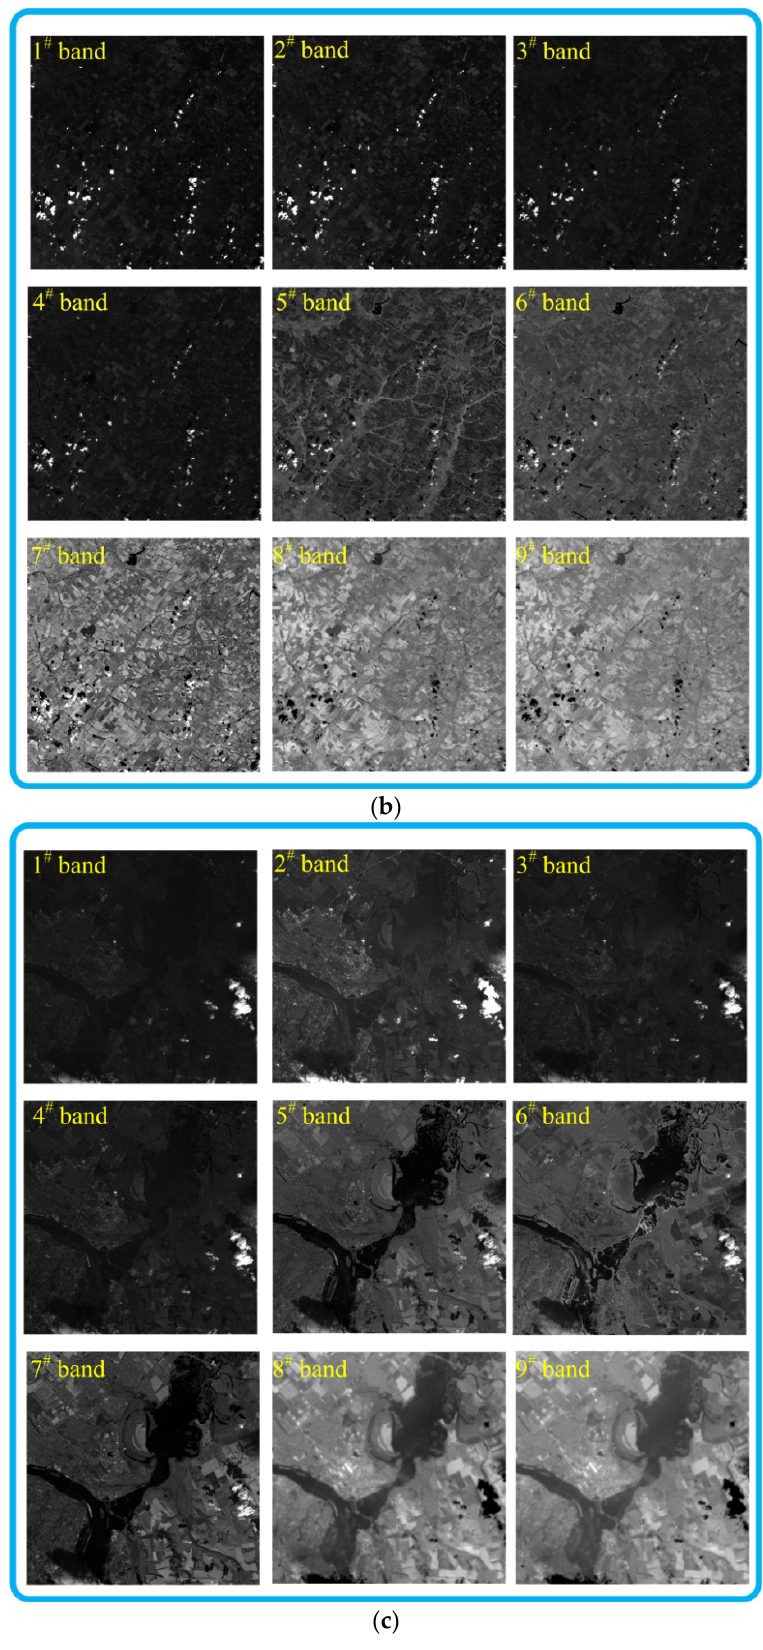
Figure 11. Multispectral database display: ( a ) cloudy multispectral data, ( b ) urban multispectral data, and ( c ) suburban multispectral data.